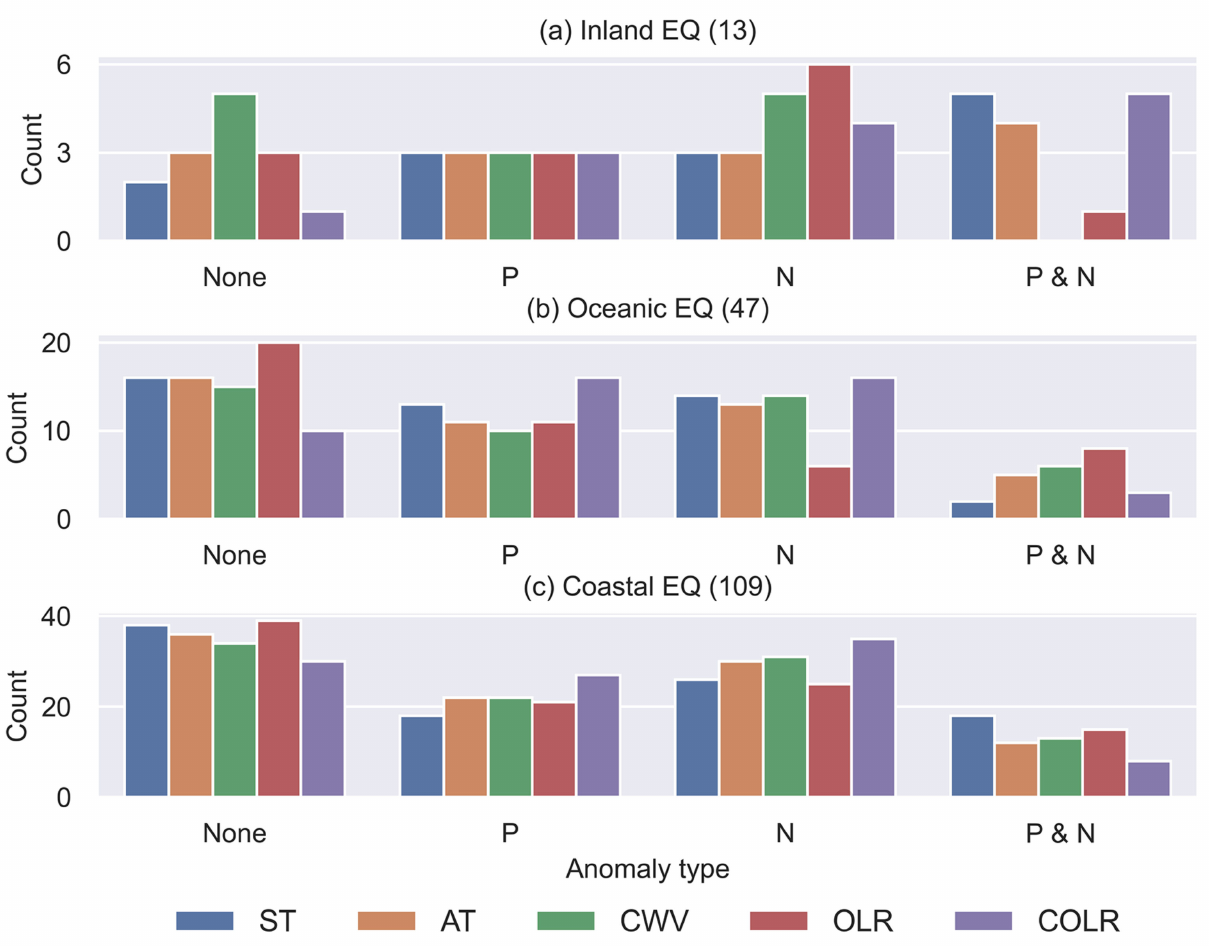
Figure 9. Statistical results of multiparameter temporal integrated anomalies (TIAs) for ( a ) inland, ( b ) oceanic, and ( c ) coastal earthquakes (EQ). ST, skin temperature; AT, air temperature; CWV, total integrated column water vapor burden; OLR, outgoing longwave radiation; COLR, clear-sky